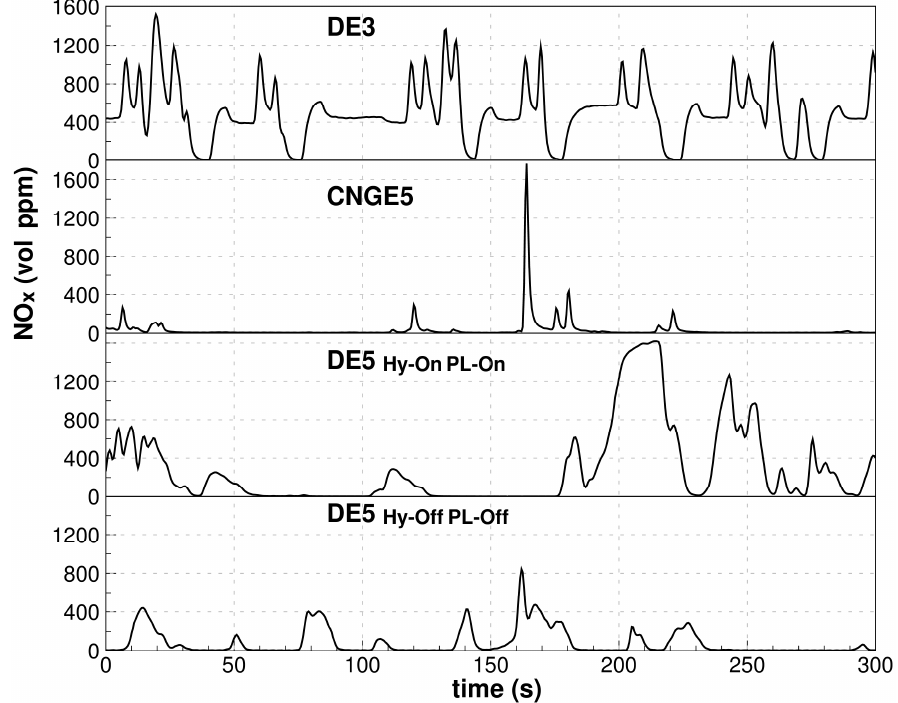
Figure 10. NO x vs time measured of the DE3 bus, CNGE5 bus, and DE5 bus in hybrid mode with power limiter on and in non-hybrid mode with power limiter off.